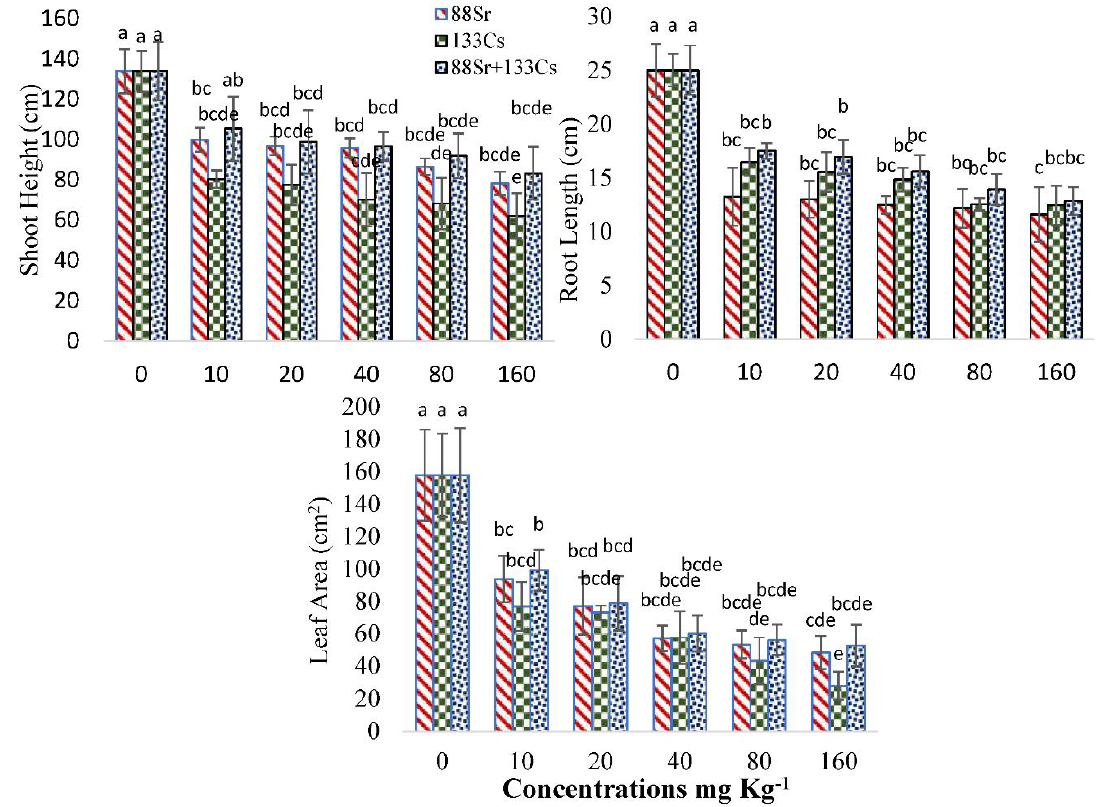
Figure 1. Shoot height, root length, and leaf area responses of cucumber to various concentrations (0 to 160 mg kg − 1 ) of 88 Sr, 133 Cs, and 88 Sr+ 133 Cs treatments. The columns sharing different letters are significantly different at p < 0.05. The error bars indicate standard deviation.